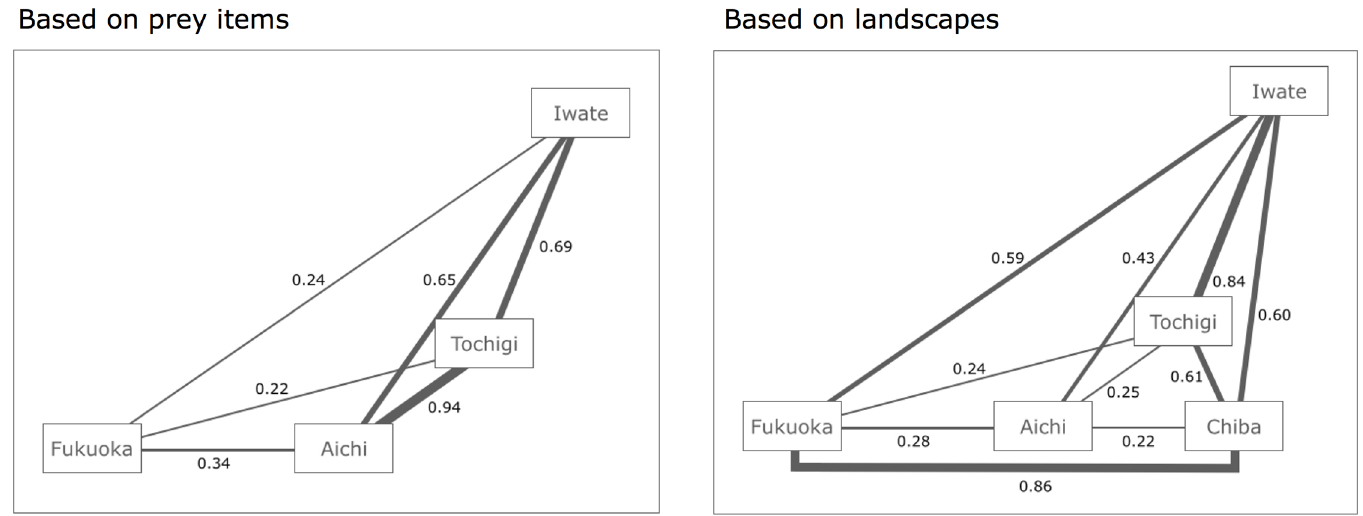
Fig 2. Jaccard similarity coefficient based on prey items and landscapes between study sites. Because there was no observation for prey items in Chiba, the indices on prey items were calculated between only four study